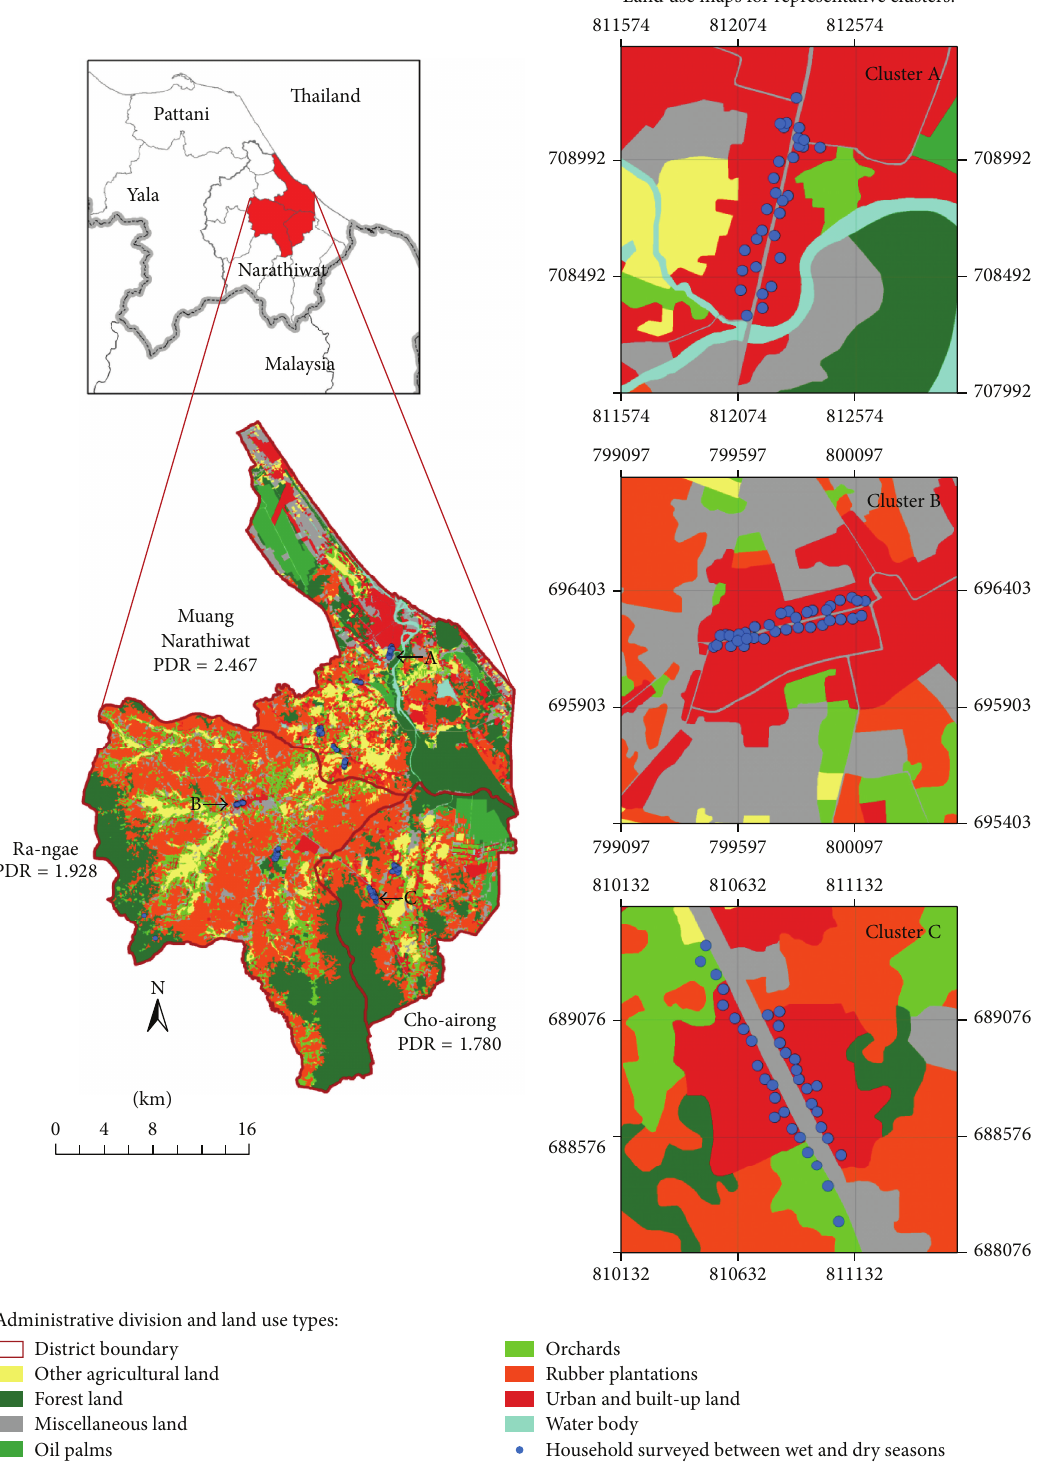
Figure 1: GIS-based land use map illustrated with two related urban and rural settings of Narathiwat. The relative population density ratio (PDR) for each district is shown to discriminate the urban-rural gradient. This approach was consistent with the degree of urbanization [9]. All 300 georeferenced houses that were used to conduct Aedes larval surveys were derived from 5 clusters of Muang Narathiwat (30 houses each), 2 clusters of Ra-ngae (40 and 35 houses), and 2 clusters of Cho-airong (40 and 35 houses). Representative cluster for each district that was assigned to a grid of 500 m 2 is shown. Miscellaneous land included roads, landfills, pits (soil, sand, and laterite), scrubs, bamboos, marsh, swamp, grass, and others. All the land use maps that were also validated by the ground surveys between 2012 and 2013 were constructed using the ArcGIS ver 10.1 software